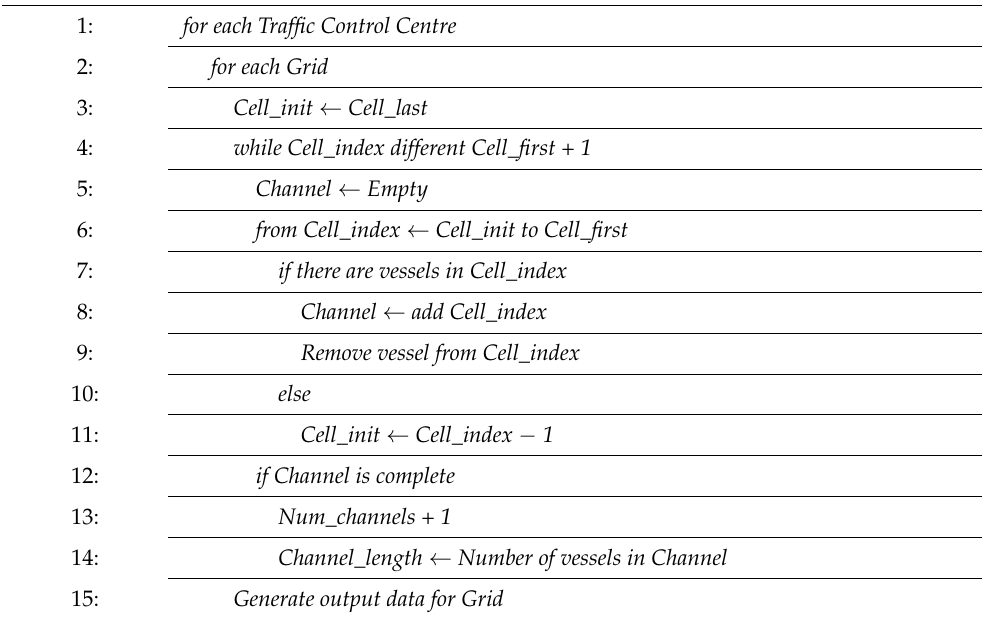
Algorithm 1 Simulation Algorithm: Number and Length of